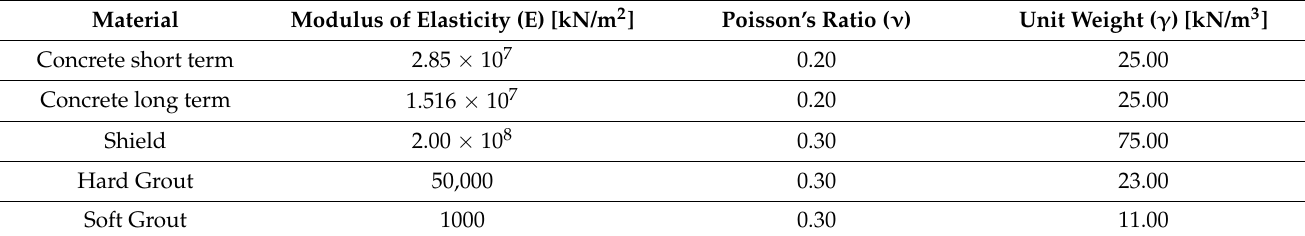
Table 4. Properties of concrete lining and grout